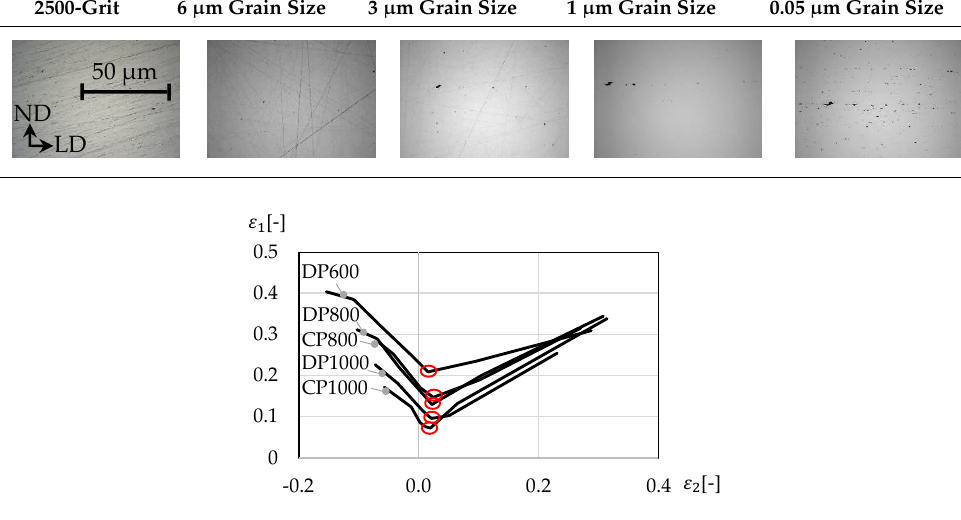
Table A13. Damage evolution of DP800.